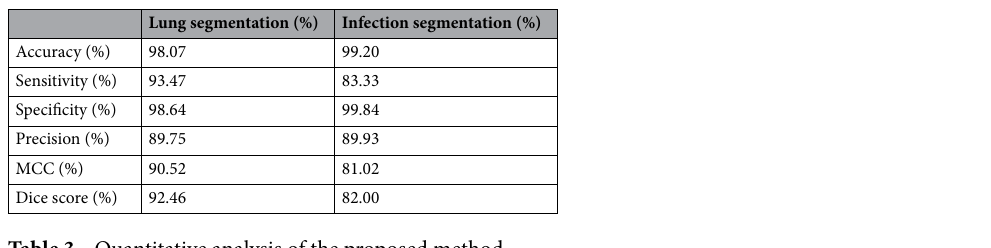
Table 3. Quantitative analysis of the proposed